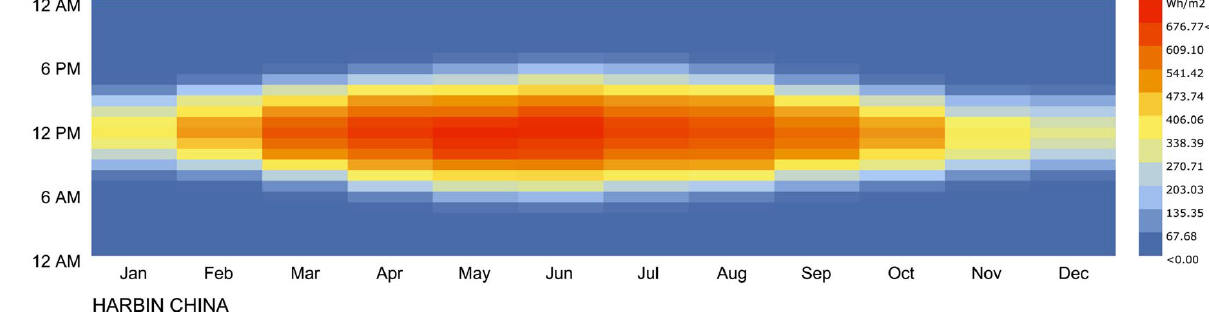
Figure 4. Solar radiation analysis diagram.